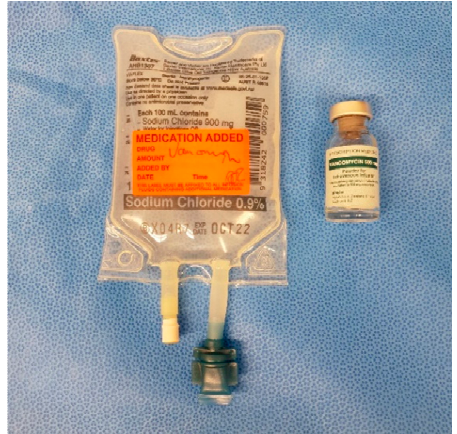
Figure 1. 500 mg vancomycin powder in 100 mL saline.